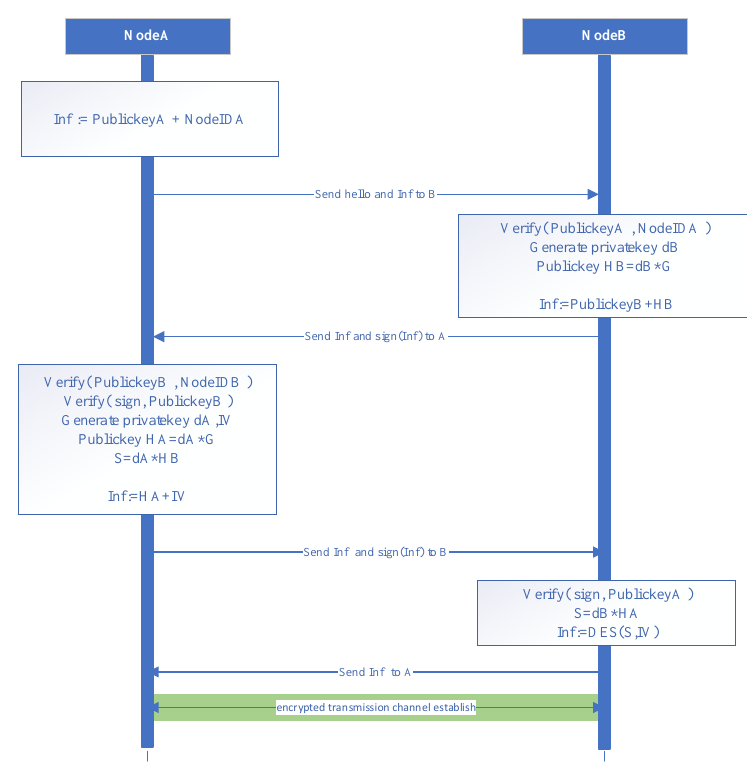
Figure 8. The workflow of confidential message